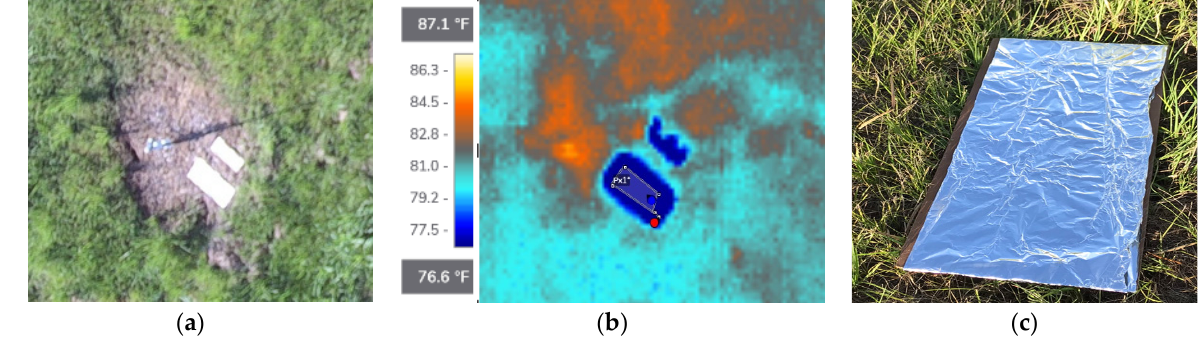
Figure 10. ( a ) Optical image of AL foil on the Terry Road site. ( b ) AL foil thermal image of the Terry Road site. ( c ) Typical AL foil placed on site.